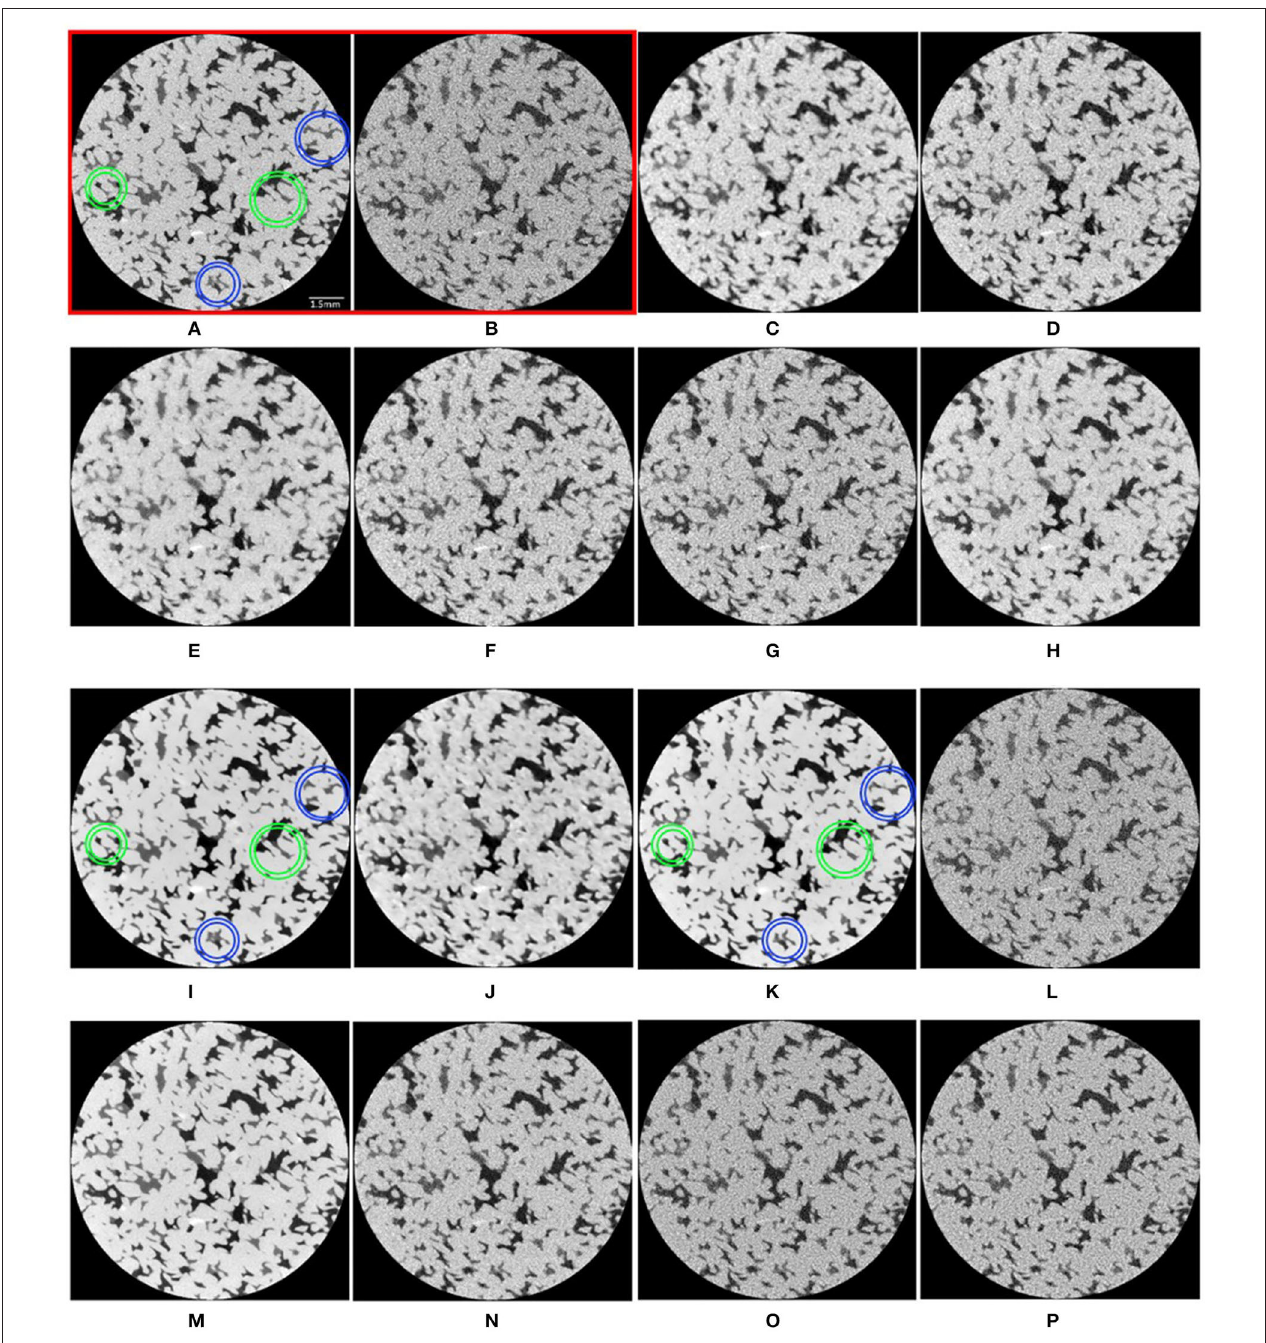
FIGURE 2 | Qualitative comparison of the performance of the different denoising methods through example cross-sectional slices. (A) , HQ reference; (B) , LQ; (C) ,Gaussian; (D) , Median; (E) , Non-local means; (F) , Anisotropic diffusion; (G) , Bilateral; (H) , Symmetric nearest neighbor; (I) , Noise-to-clean; (J) , Residual dense network; (K) , Cycle consistent generative adversarial network; (L) , Noise-to-void; (M) , Noise-to-noise (75%); (N) , Noise-to-noise (50%); (O) , Noise-to-noise (25%); (P) ,Noise-to-noise.